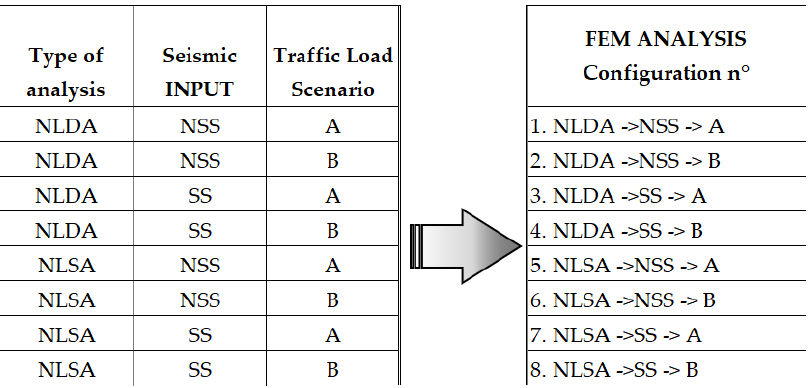
Figure 8. Comparative configurations of the analysis strategies undertaken.